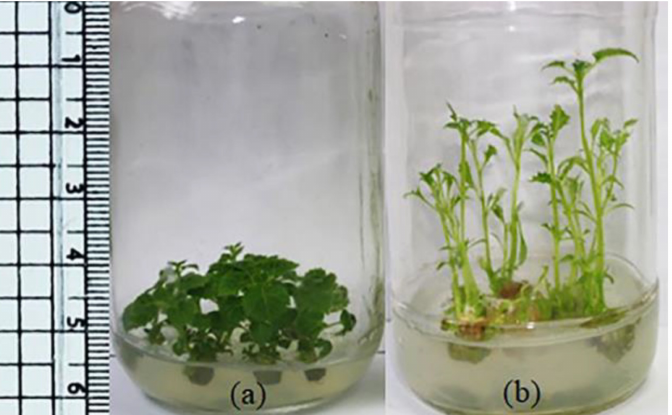
Figure 1. Multiplication of paulownia on semisolid MS medium containing 2 mg/L BAP and